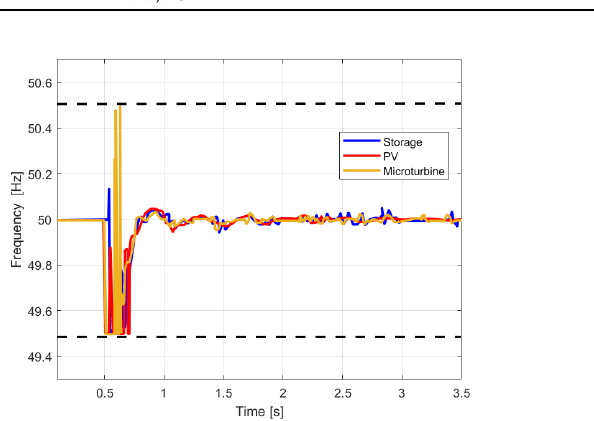
Figure 9. Simulation B: Frequencies. The dashed black lines represent the frequency limits f min and f max .